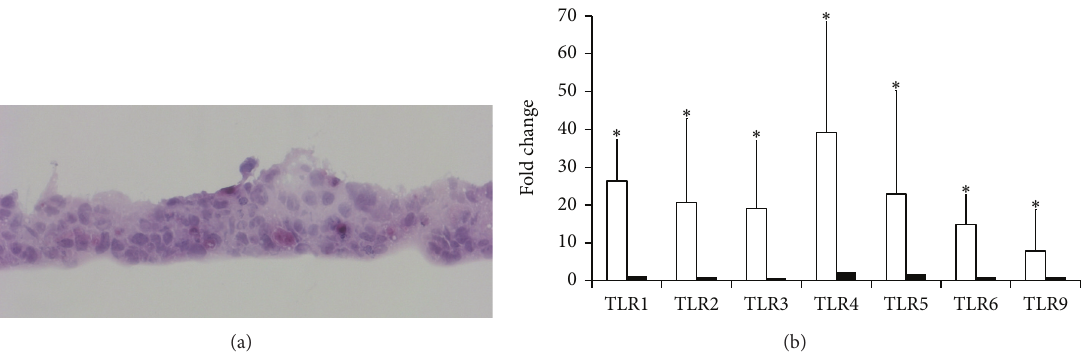
Figure 1: TLR mRNA expression in airlifted primary human conjunctival epithelial cells. (a) Hematoxylin and eosin staining of a representative cell sheet 7 days after airlifting culture. Typically, the cell sheet was composed of 3-4 layers of cells. Cells at the bottom were mostly cuboidal and more compact than the cells at the upper layers. (b) Averaged fold increase of individual TLR mRNA in airlifted (white bars) and replated conjunctival epithelial cells (black bars). Cells were harvested 10 days after airlifting culture. Half of the cells were replated to 6-well plate and submerged-cultured for 24 hrs in 1: 1 medium with full supplement before being lysed for RNA extraction. TLR mRNA level was determined by qPCR and compared to the same batch of cells submerged-cultured. Three different batches of cells were analyzed, and the fold increase was averaged. 𝑌 error bars represent the standard deviation of the averaged results. Asterisks ( ∗ ) denote significant difference ( 𝑃 < 0.05 ) between airlifted and replated